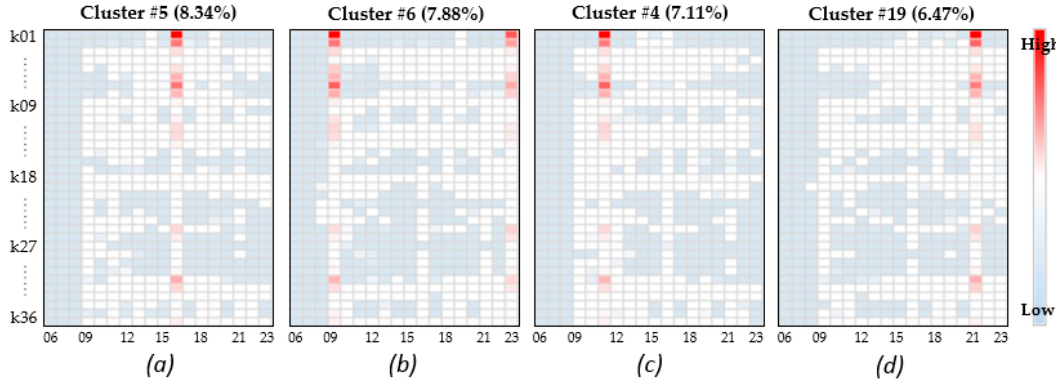
Figure 11. Perplexity value for U21 and U23. ( a ) Perplexity value for U21; ( b ) Perplexity value for U23.